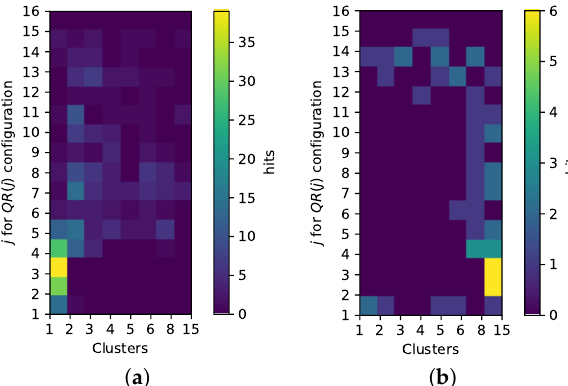
Figure 4. Comparison between the general trend and outlier behavior of the CPR image. Both figures obtained following the same technique used for Figure 3a,b. ( a ) General trend when changing the number of clusters and QR ( j ) configuration. Results improve slightly with the number of clusters at high values of j ; ( b ) Outlier behavior of the CPR image, which is better compressed at lower j values for QR ( j ) when using a high amount of clusters.